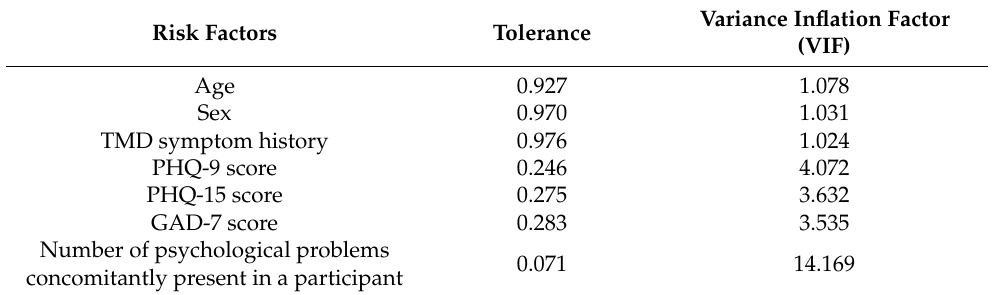
Table 6. Multicollinearity test among potential risk factors correlated with condylar bony changes.